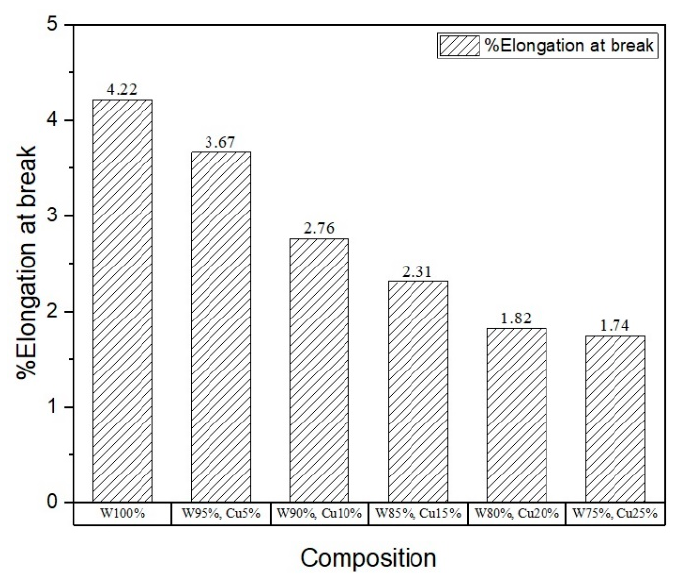
Figure 6. Plot of yield strength.